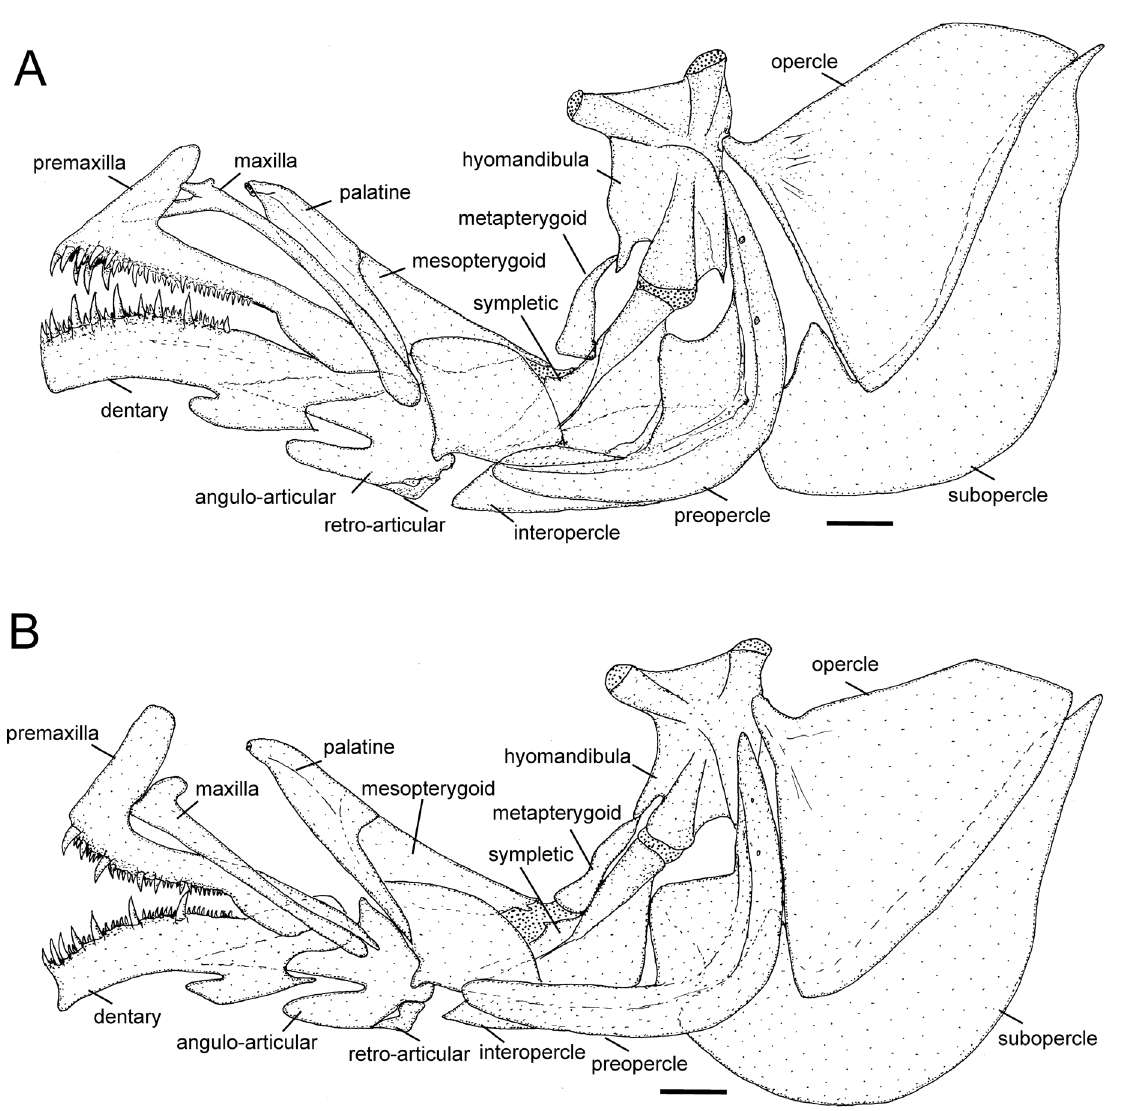
Figure 4. Jaws, jaw suspensorium and opercular apparatus, left side, lateral view, of: A. Nothobranchius lucius , paratype, male, MRAC A7-02-P-10-25, 43.0 mm SL; B. N. melanospilus , male, UFRJ 6591, 43.5 mm SL. Larger stippling indicates cartilage. Scale bar = 1